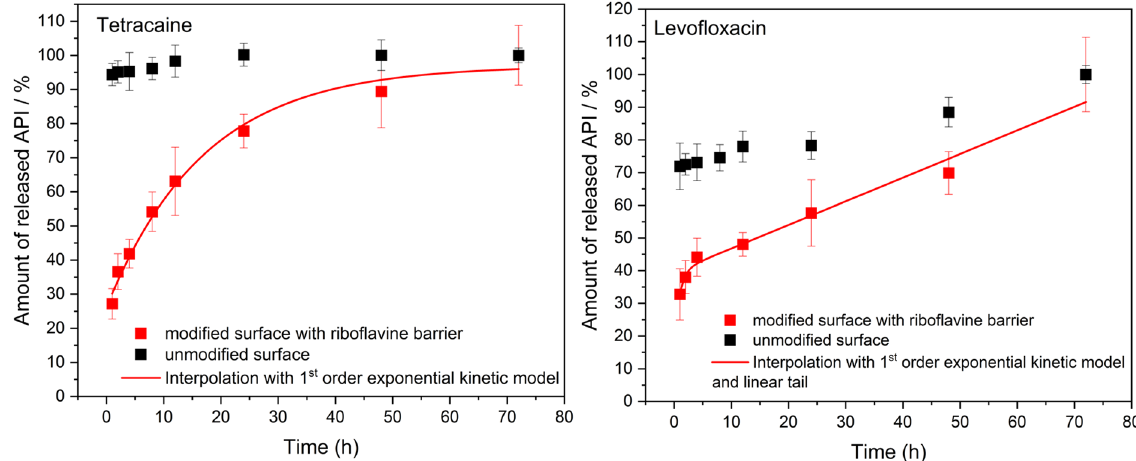
Figure 5. Tetracaine ( left ) and Levofloxacin ( right ) release profiles from unmodified (black) and surface ‐ crosslinked (red) collagen drug carriers. The number of samples was 3 for each measurement.